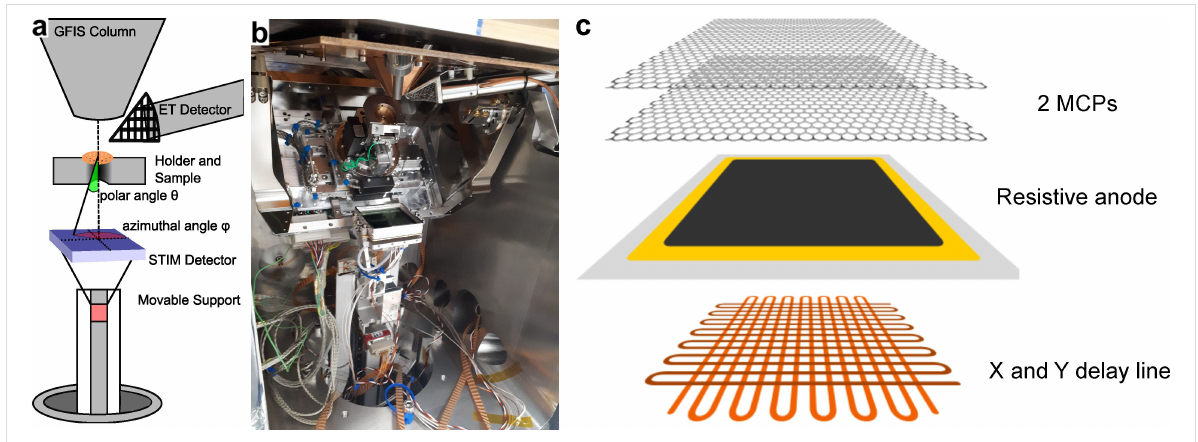
Figure 1: (a) Schematic representation of the STIM experiment. (b) Picture of the inner part of the chamber. (c) Schematic representation of the STIM detector.